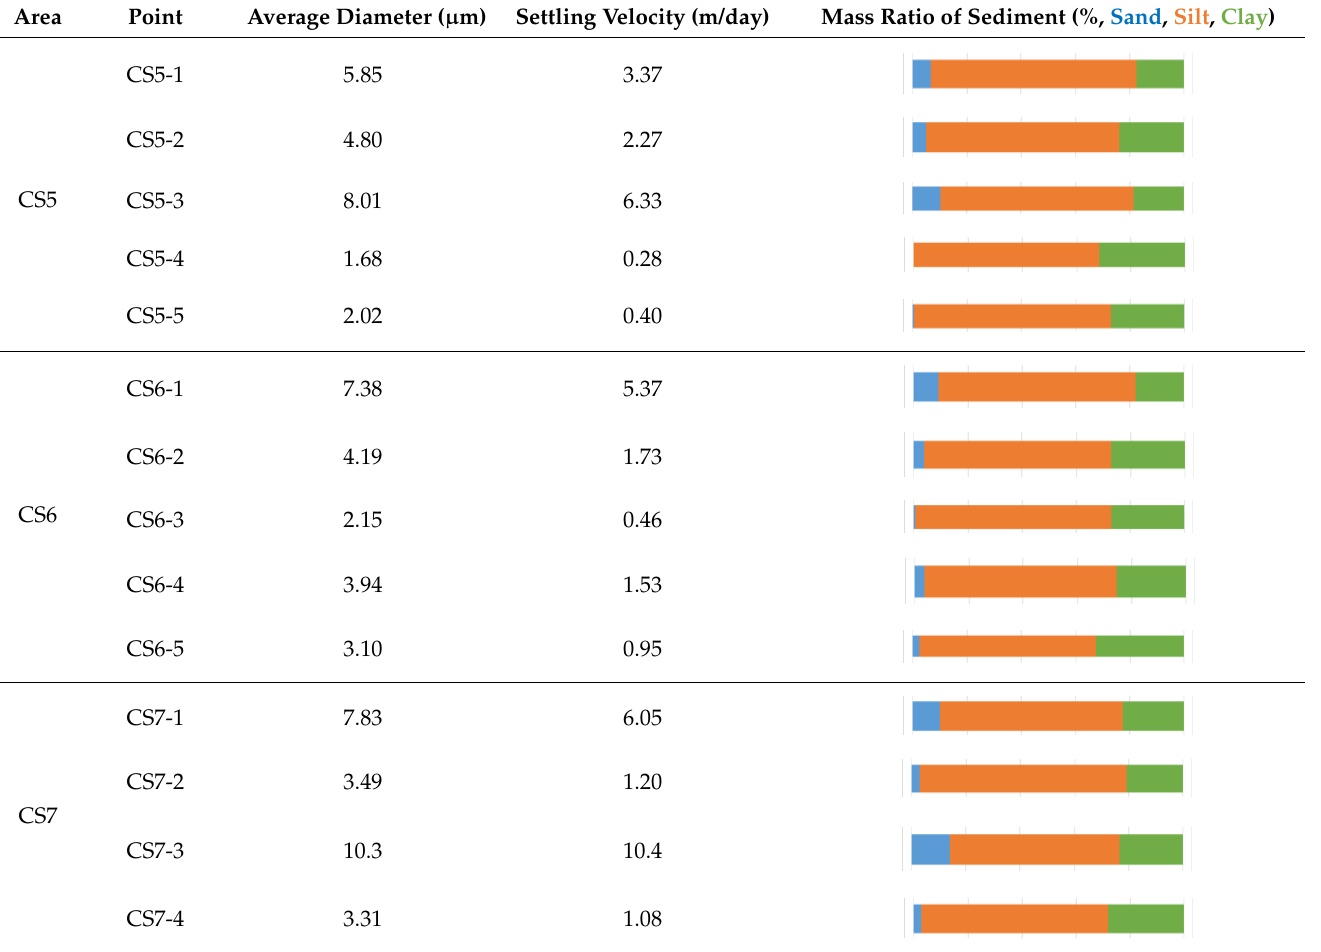
Interpolated wind Speed TSS